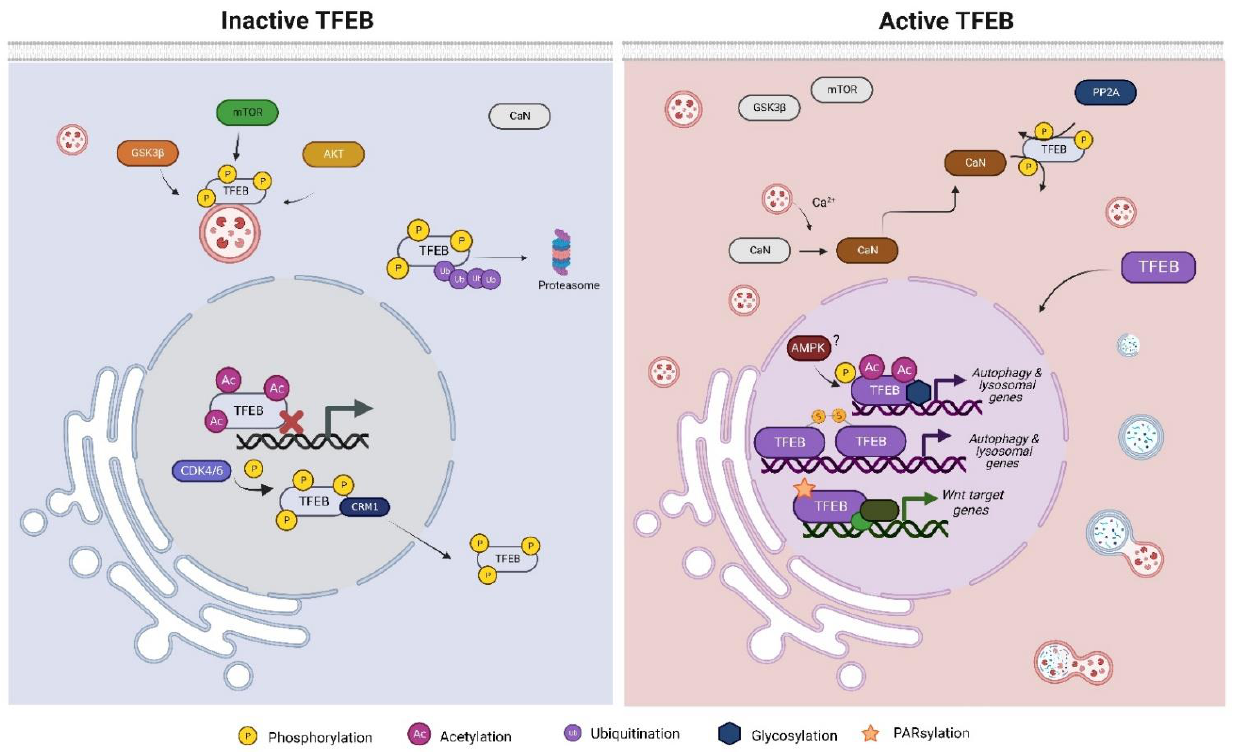
Figure 1. The TFEB activity is regulated by post-translational modifications. TFEB is mainly phos- phorylated to avoid its nuclear translocation; however, depending on the cellular context, TFEB can be dephosphorylated, acetylated, glycosylated, or PARsylated.